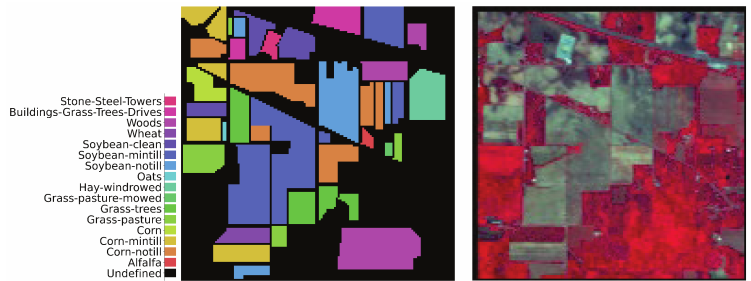
Figure 7. Indian Pines dataset: Left is the names of classes, Center is ground truth, Right is the RGB image.